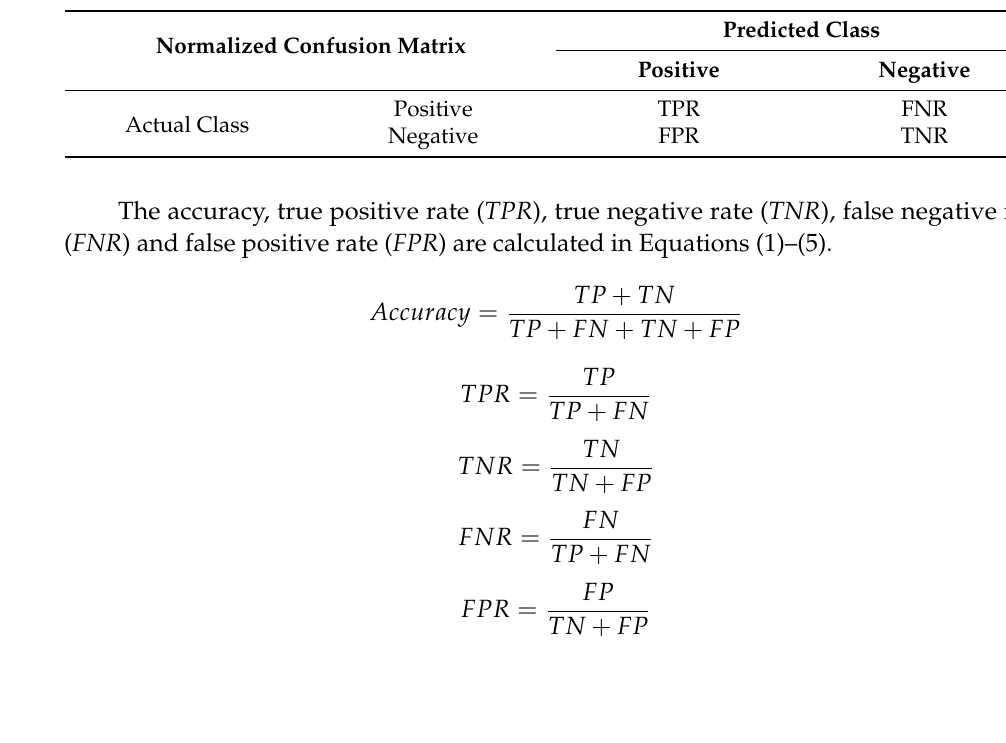
Table 2. An illustration of normalized confusion matrix in two-class